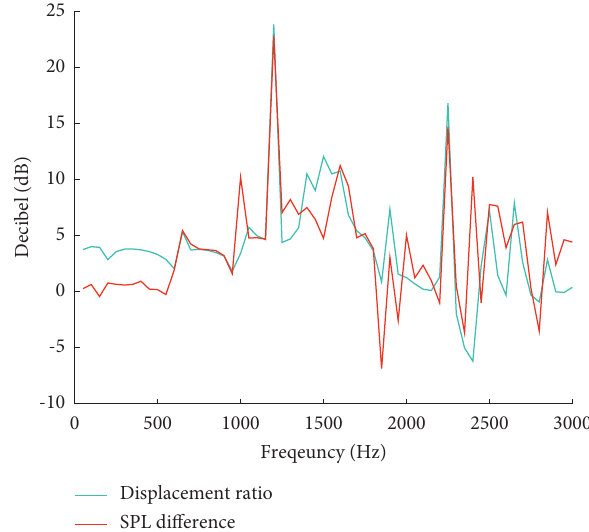
Figure 7: Comparison between the displacement ratio and SPL difference of the conventional and optimized gradient coils over the frequency range from 0 to